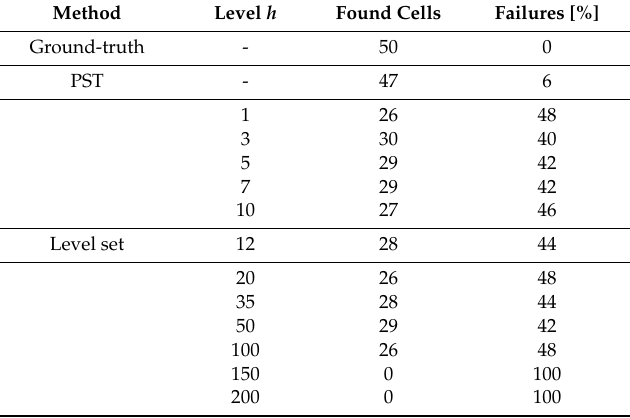
Table 5. Results obtained with the proposed method and the BSMI technique. Method